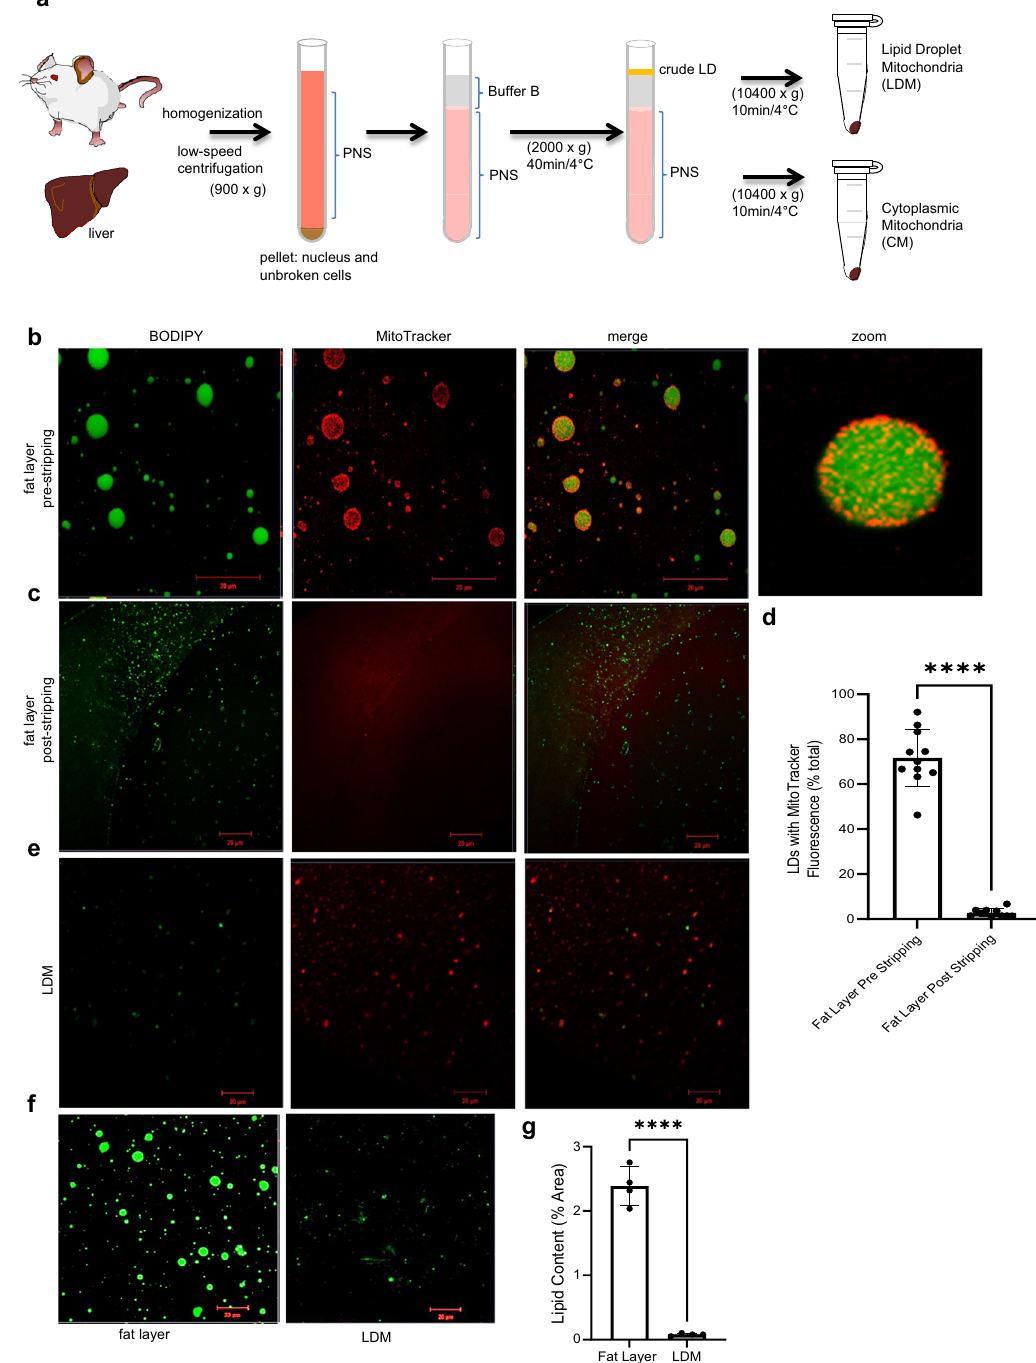
Fig. 2 | Isolation of Lipid Droplet associated Mitochondria (LDM) by differ- entialcentrifugationfromratliver.a Schematicrepresentationofthemethodto isolate LDM and Cytosolic Mitochondria (CM) from rat liver. The liver was dis- sected from Wistar rats and homogenized with a polytron homogenizer. Low- speedcentrifugationseparatedthepost-nuclearsupernatant(PNS)fromthepellet. PNS was layered with buffer B and subjected to centrifugation to separate the fat layer that contains crude LD and the supernatant containing CM. High-speed centrifugationstripped LDMfrom LD, and CMwaspelleted from supernatant PNS fraction.Confocalimagesofthefatlayerbefore( b )andafter( c )strippingofLDMs. LDsweremarkedbyBODIPY fl uorescentdyeandmitochondriabyMitoTrackerred dye. Note the preservation of LD-mitochondria contacts in the fat layer before stripping (b, zoom). Also, note that LDM has been effectively stripped of LD ( c ,MitoTracker)(scalebar,20 μ m).Experimentwasperformedwithtwobiological